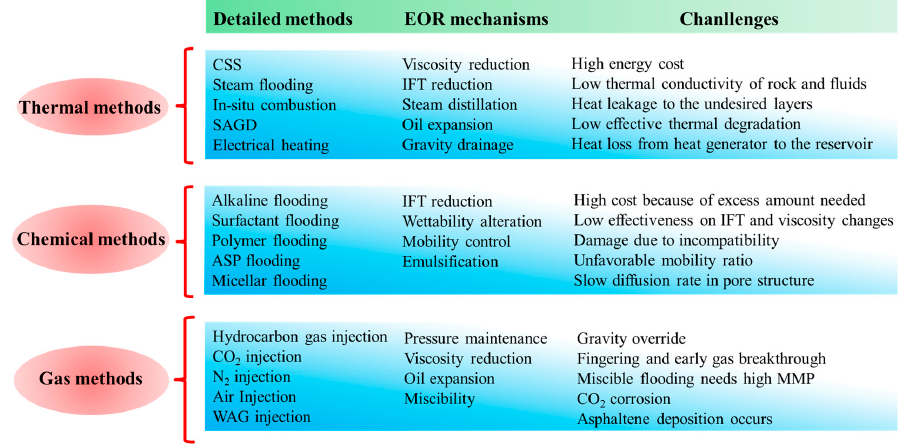
Figure 1. The categories of available EOR technologies.